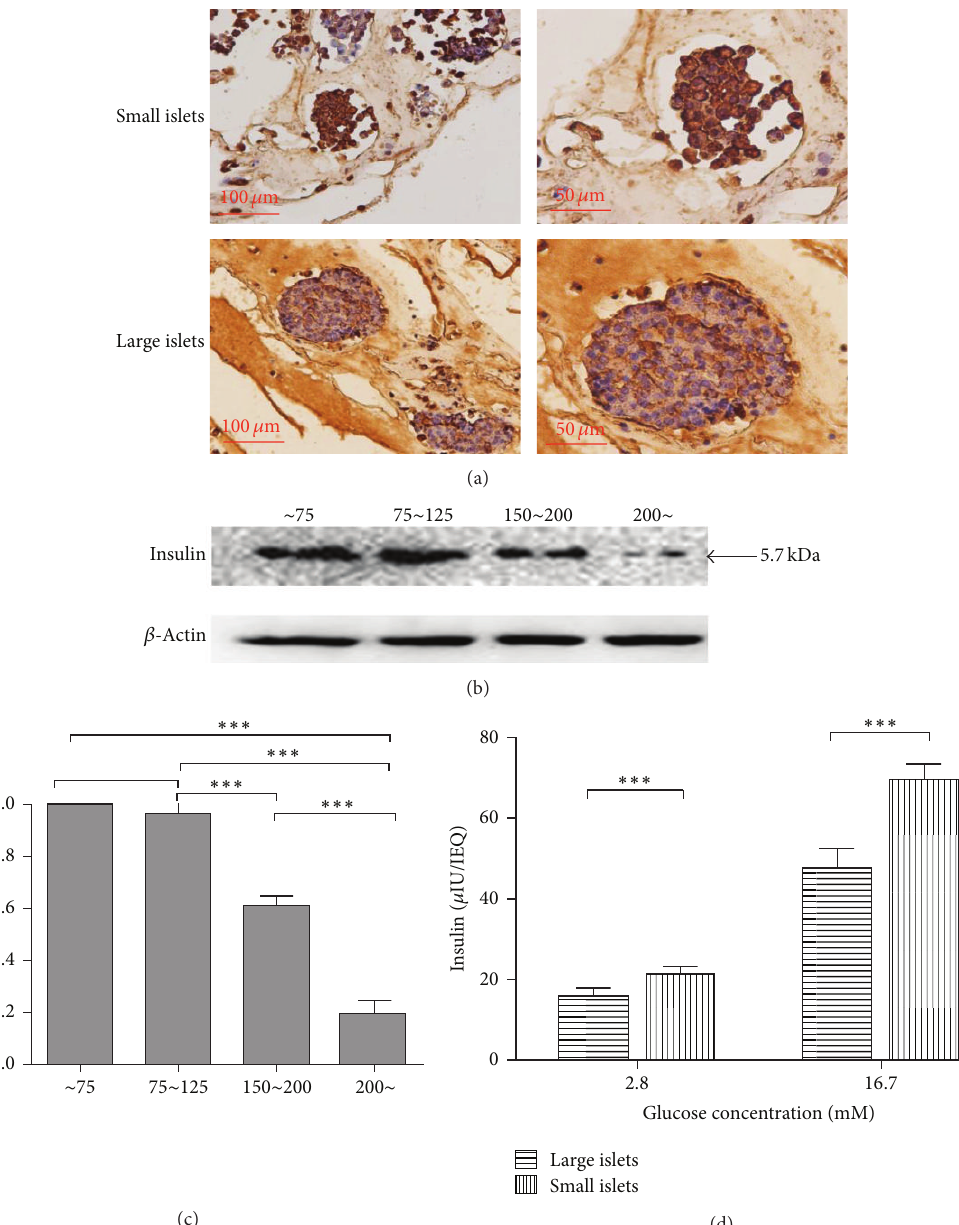
Figure 3: Small islets embrace more insulin-producing 𝛽 -cells and function more vigorously. (a) Insulin immunostaining (brown) of islets in situ in the sectioned pancreas. Small islets showed an apparent more distinct and dense insulin staining compared with the large ones. (b) Immunoblotting of insulin in isolated islets of indicated size. (c) Quantification of insulin immunoblotting above. Small islets have more insulin reservation than large ones normalized to total protein content ( 𝑃 < 0.0001 ). (d) In vitro glucose stimulated insulin secretion assay of isolated islets. Small islets represent more potent insulin-secretion ability both in basal state (2.8 mM glucose) and after 16.7 mM glucose challenge ( 𝑃 = 0.0007 and 𝑃 < 0.0001 ,